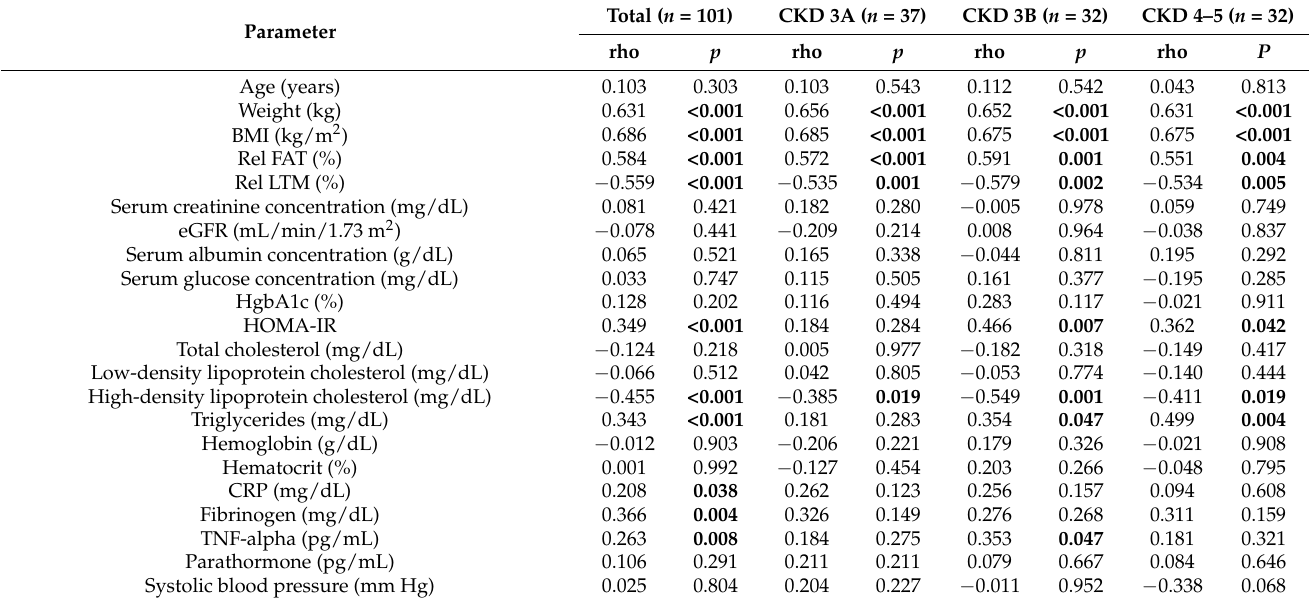
Table 4. Leptin correlations with clinical and biochemical